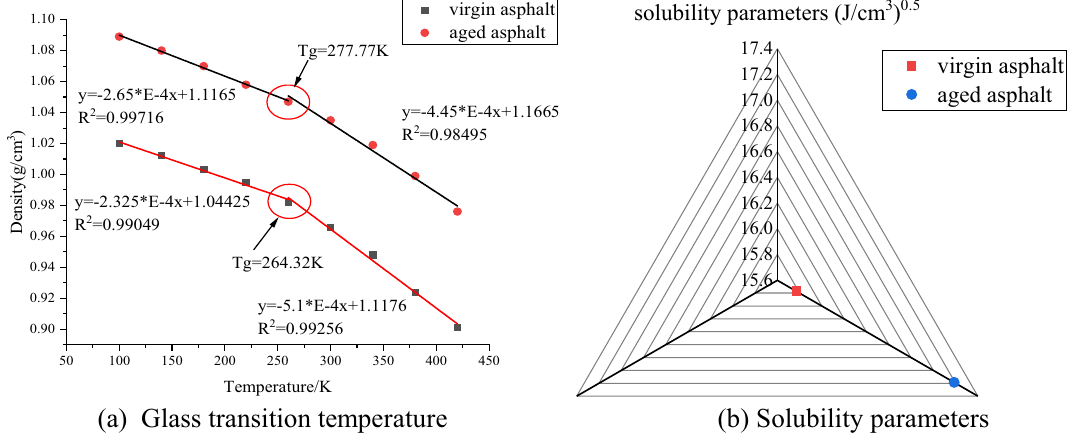
Figure 3. Glass transition temperature and solubility parameters of asphalt